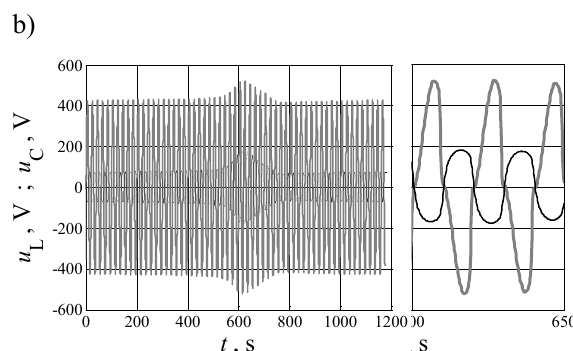
Fig. 1. Measured waveforms of circuit current (gray) and computed nonlinear coil magnetic flux (black) (a) and nonlinear coil (gray) and linear capacitor (black) measured voltage waveforms (b) during ferroresonance (the scale is common for both